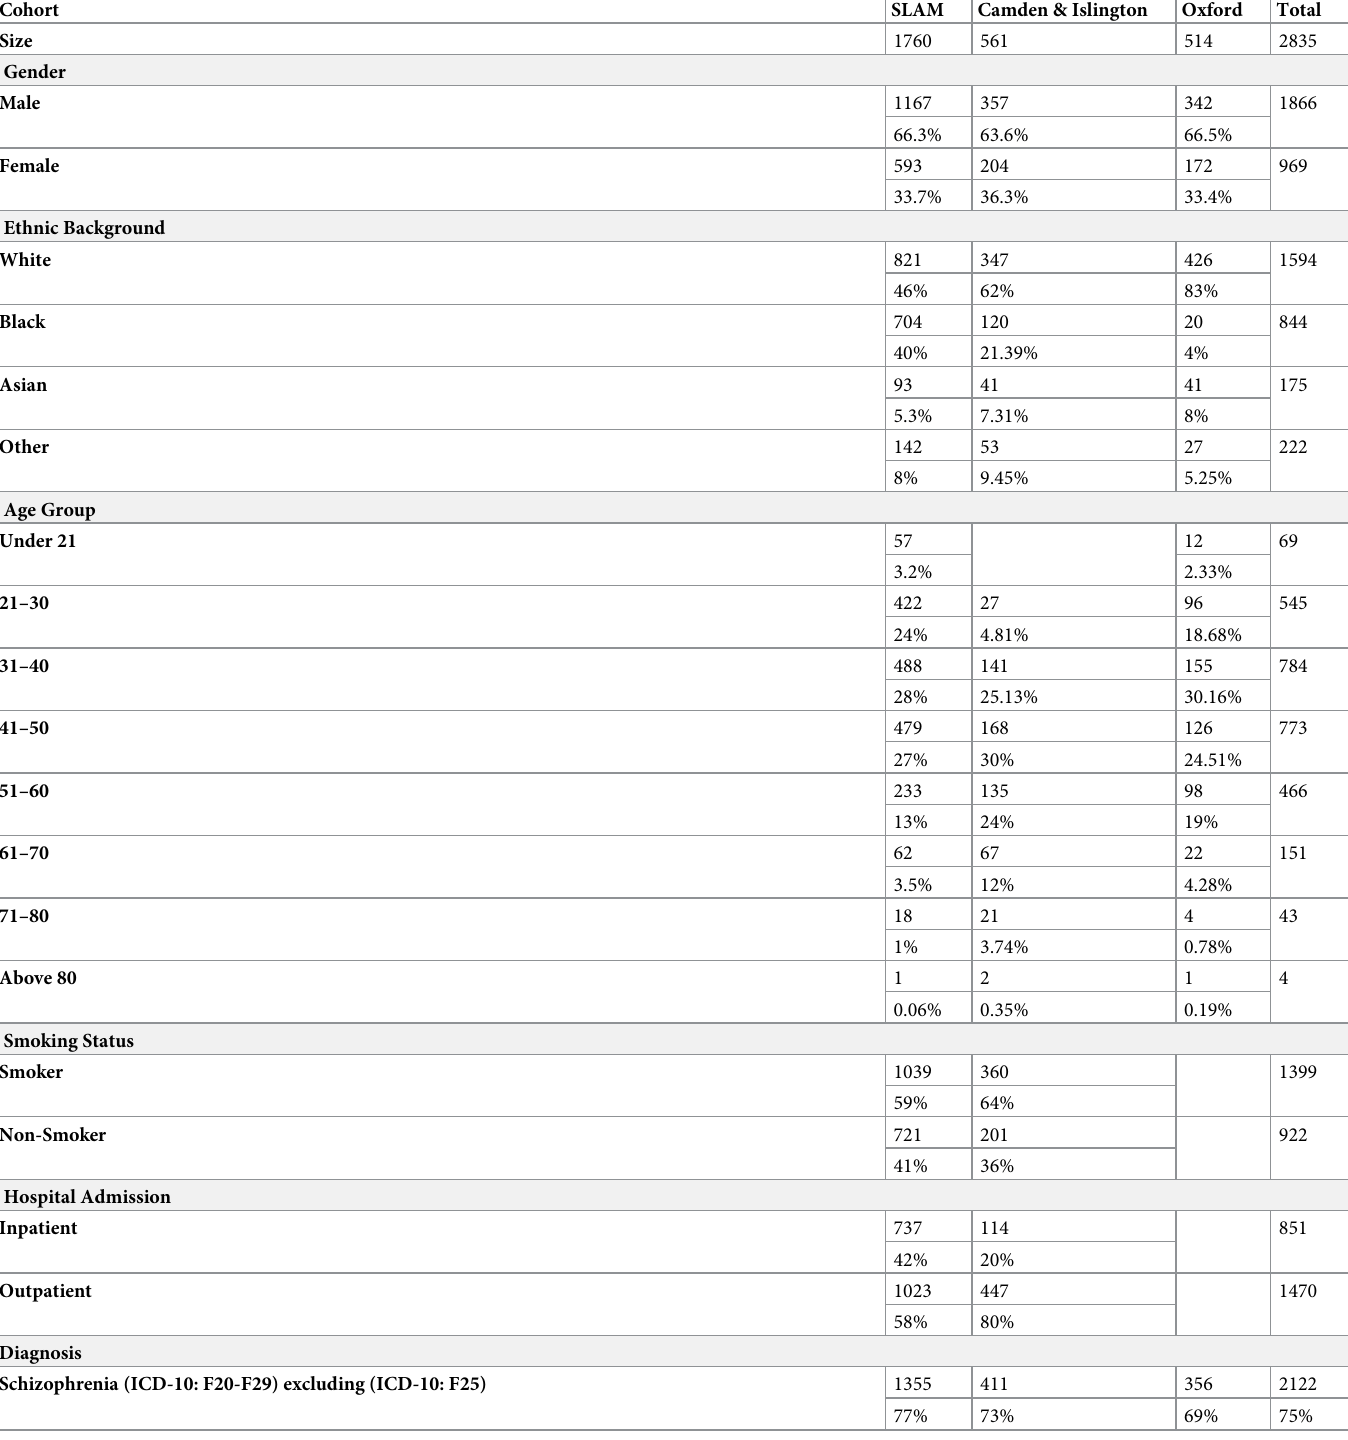
Table 1. Cohort characteristics of the three NHS trusts, showing a breakdown of gender, ethnic background, age groups, smoking status, hospital admission and